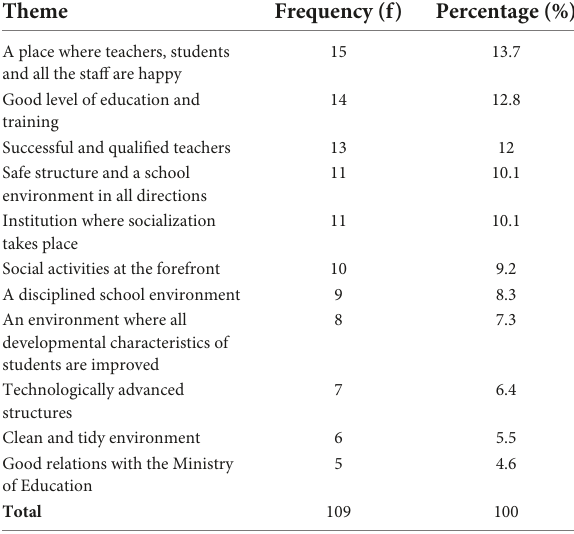
TABLE 1 Demographic characteristics of the participants. Number Gender